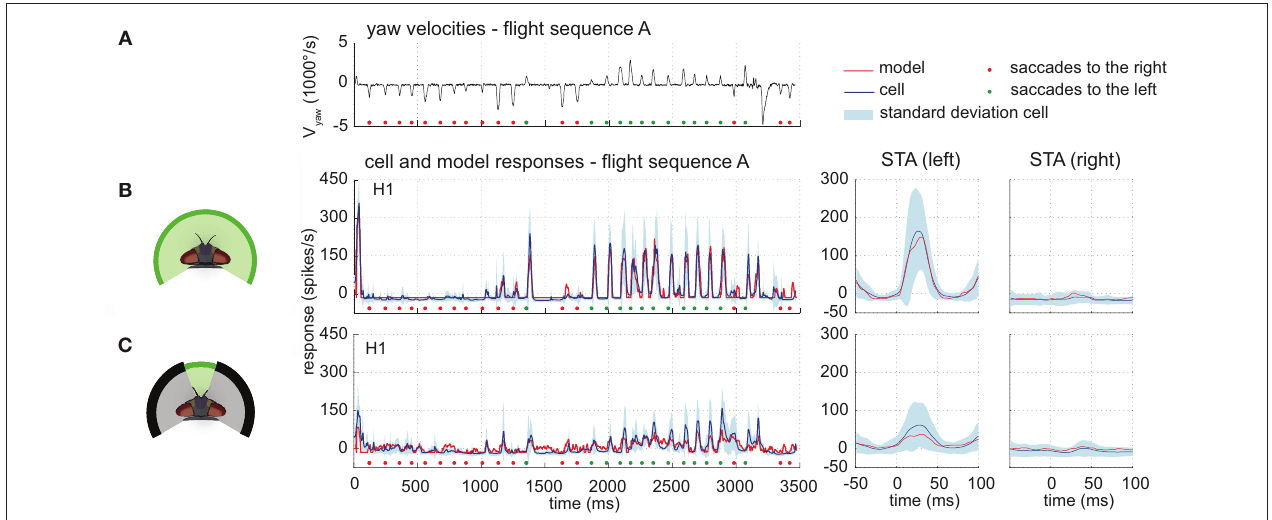
Figure 6 | Model performance H1-cell. Electrophysiologically measured and modeled responses of the H1-cell to naturalistic motion stimulation of different parts of the visual field. (A) Head yaw velocities plotted against time for flight sequence A. (B,C) Responses and STAs of the left H1-cell (blue) and model (red) to flight sequence A and different parts of the visual field stimulated as depicted at the left of each row. All further color and sign codes as in Figure 4 .